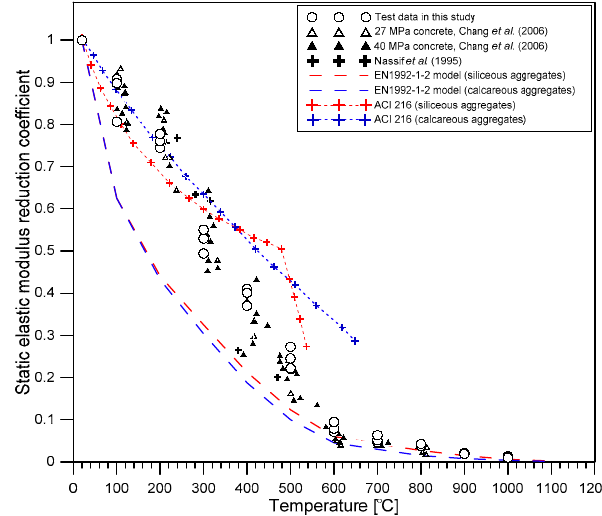
Figure 11. The variation of reduction coefficient in the static elastic modulus of concrete with